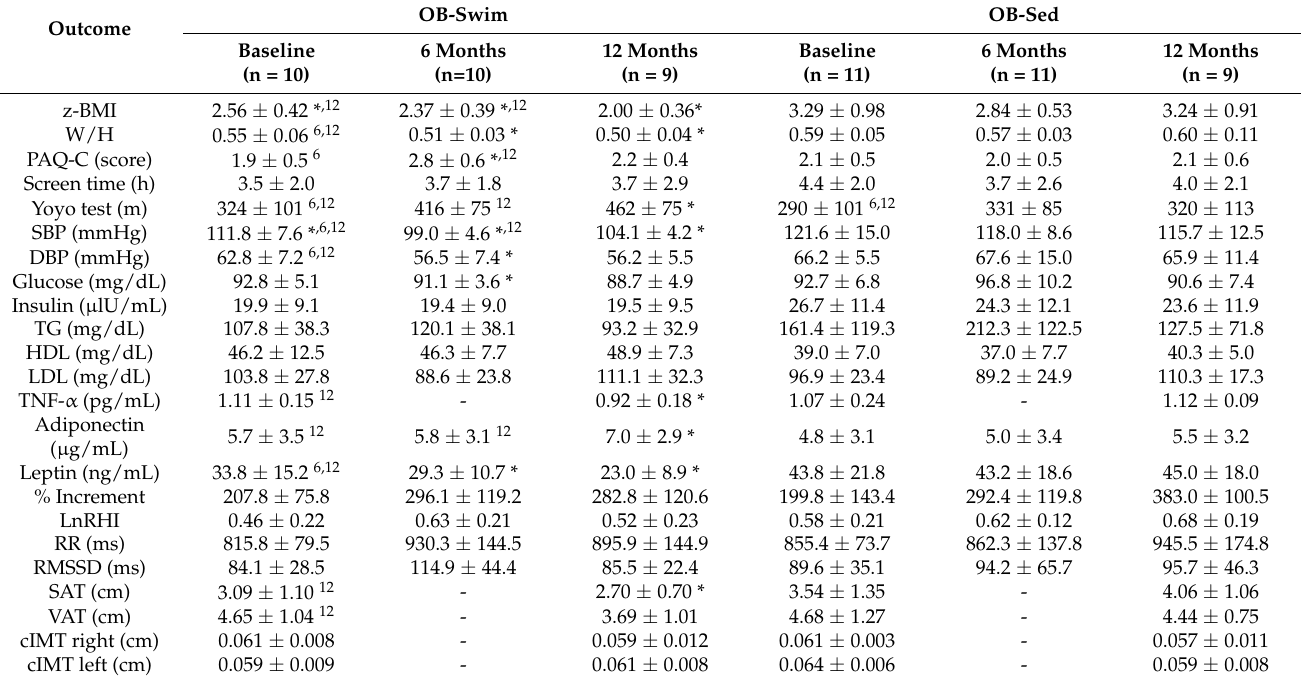
Table 3. Data of anthropometry, physical activity level, screen time, cardiorespiratory fitness, blood pressure, biochemical markers, endothelial function, autonomic modulation, and ultrasound out- comes in ‘obese swimming’ (OB-Swim) and ‘obese sedentary’ (OB-Sed) groups at baseline and after 6 and 12 months of